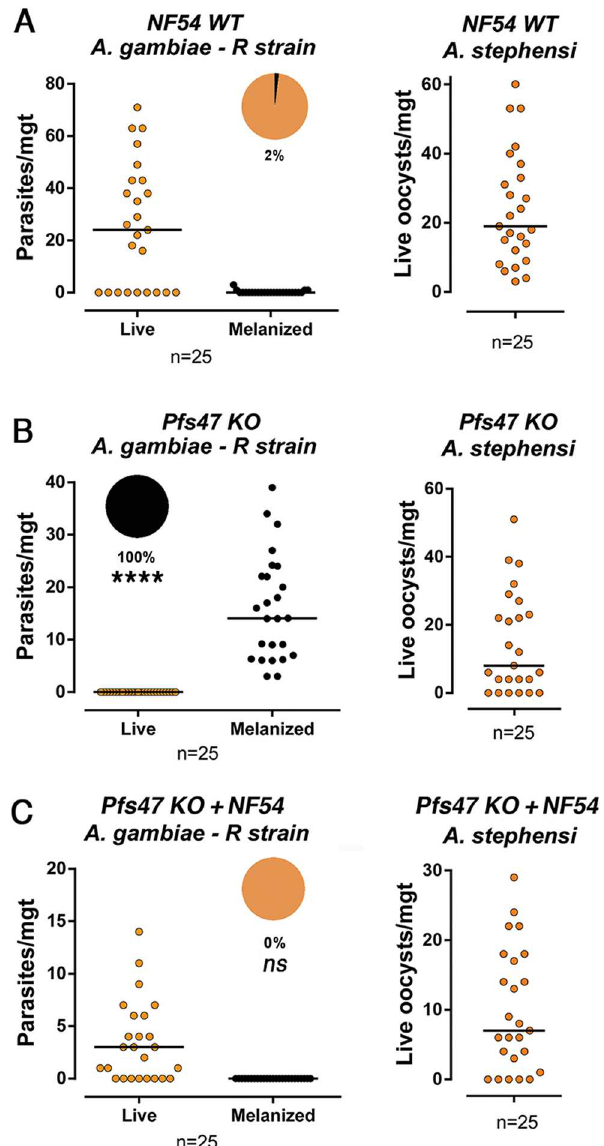
Fig 1. Infection phenotype of different P . falciparum lines (NF54 WT, Pfs47 KO, Pfs47 KO + NF54) in the A . gambiae R strain midgut 7–9 d postfeeding. Live and melanizedparasiteson individualmosquito midguts in the A . gambiae R strain and confirmation of gametocyte viabilityin the susceptible A . stephensi Nijmegenusing P . falciparum NF54 (A), Pfs47 KO (B) and Pfs47 KO + NF54 (C). The mediansare indicated with black lines and proportionof live (orange)and melanized(black) parasites are indicatedwith pie charts. Each dot represents the number of parasiteon an individualmosquitoand the medianis indicatedwith a black line (n = number of midguts examined). The differences in the proportionof melanizedparasites relativeto NF54 WT were analyzedusing the X 2 test, **** p < 0.0001,ns = not significant.All parasite phenotypes were confirmedin two independentexperiments (S1